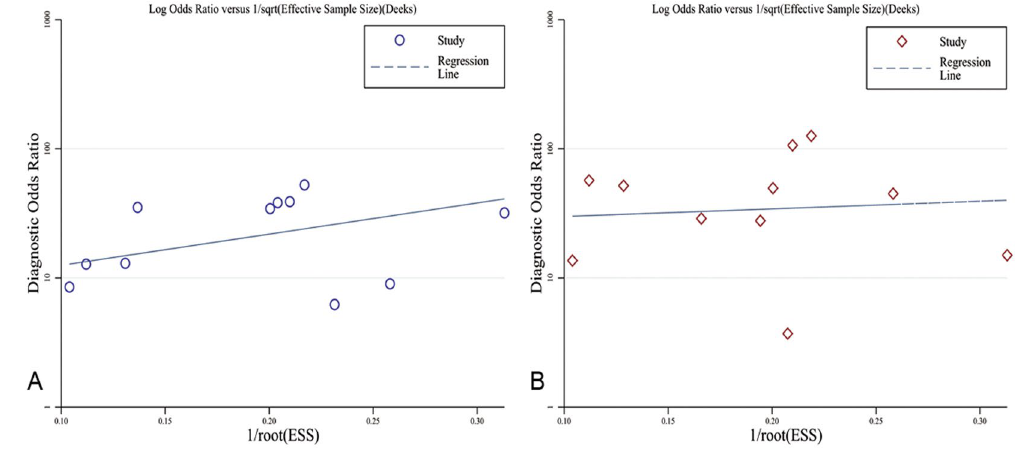
Figure 5. Funnel plot of publication bias. ( A ), MRI P = 0.160; ( B ) PET/CT P = 0.804.